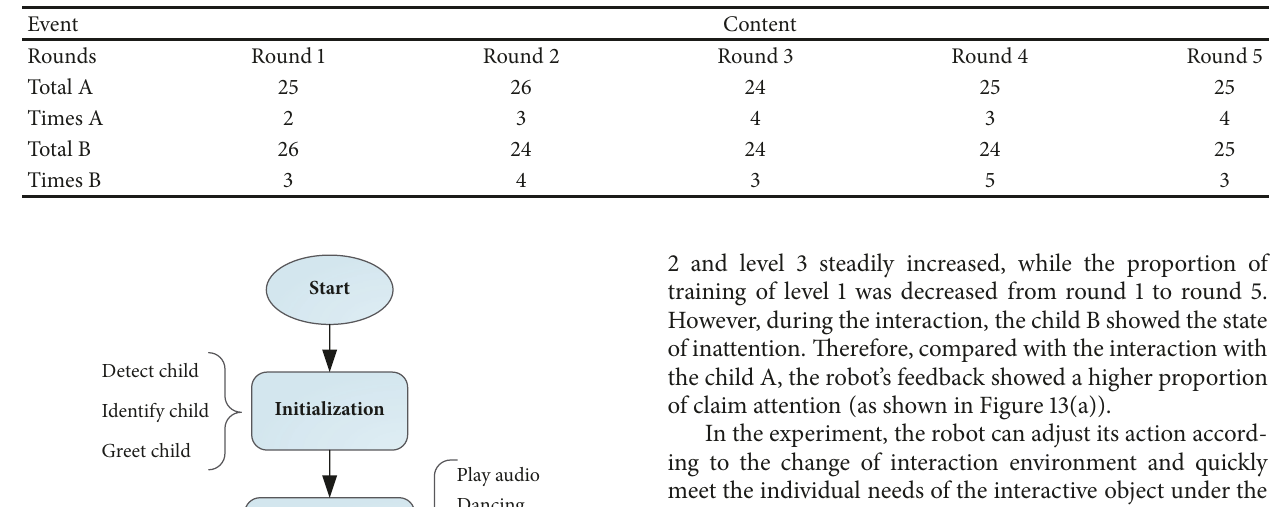
Table 3: The times of the supervisor intervenes during interaction.